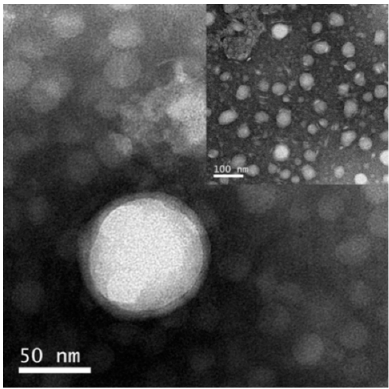
Figure 3. The TEM images of RSANs.